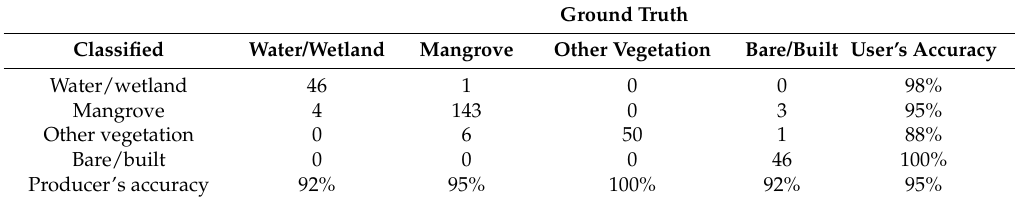
Table 3. Accuracy assessment for the 2016 classified map. The overall accuracy is shown in